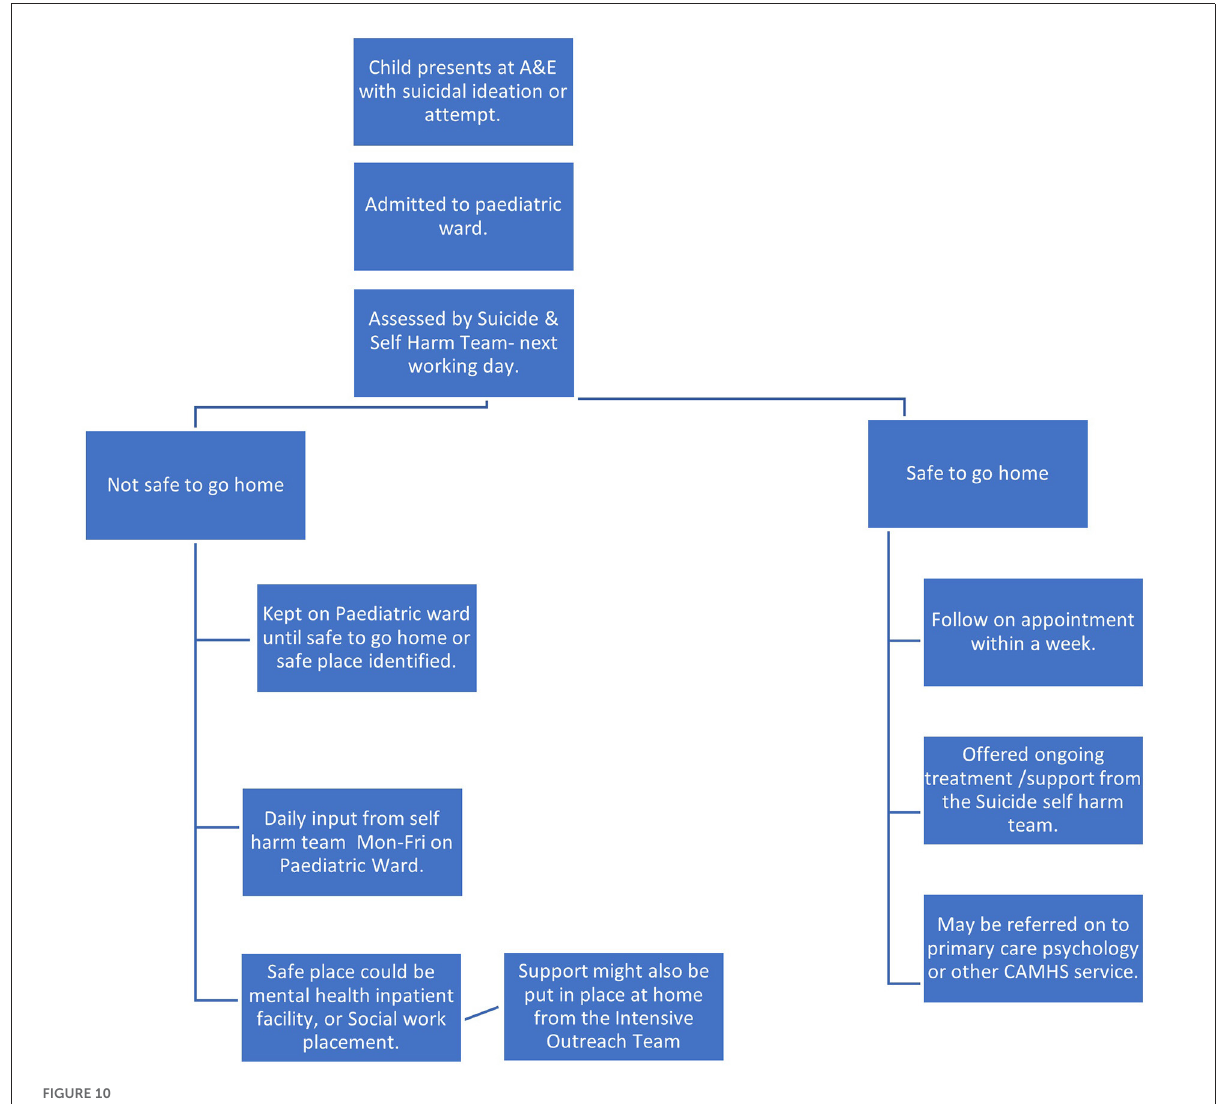
FIGURE10 Referral pathway for children referred to CAMHS from A&E (Site B).